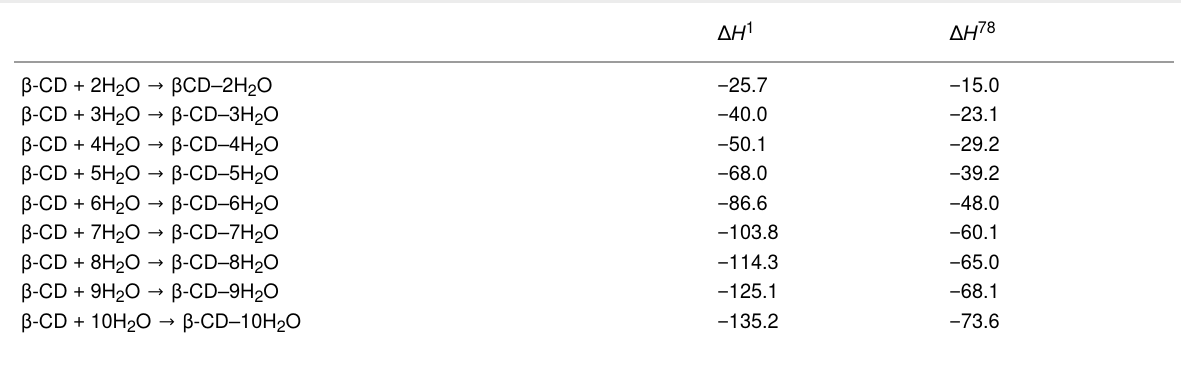
Table 2: Formation energies (in kcal mol − 1 ) calculated at the M062X/6-31G(d,p) level of theory of β -CD– n H 2 O ( n = 1–10) complexes with nonhydrogen-bonded water molecules.